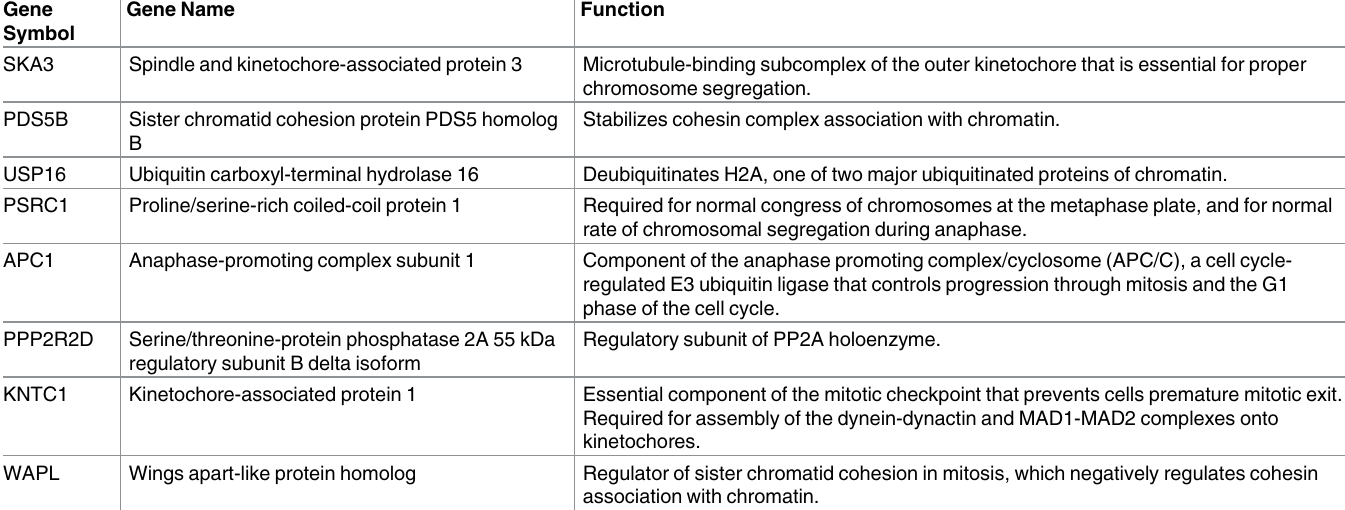
Table 3. Predicted TTK phosphorylation substrate with known mitotic